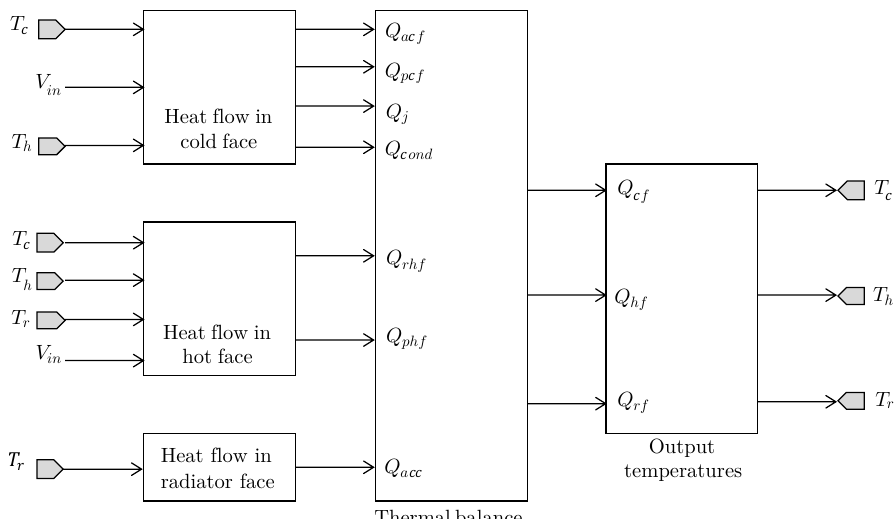
Figure 16. Block diagram of the thermoelectric